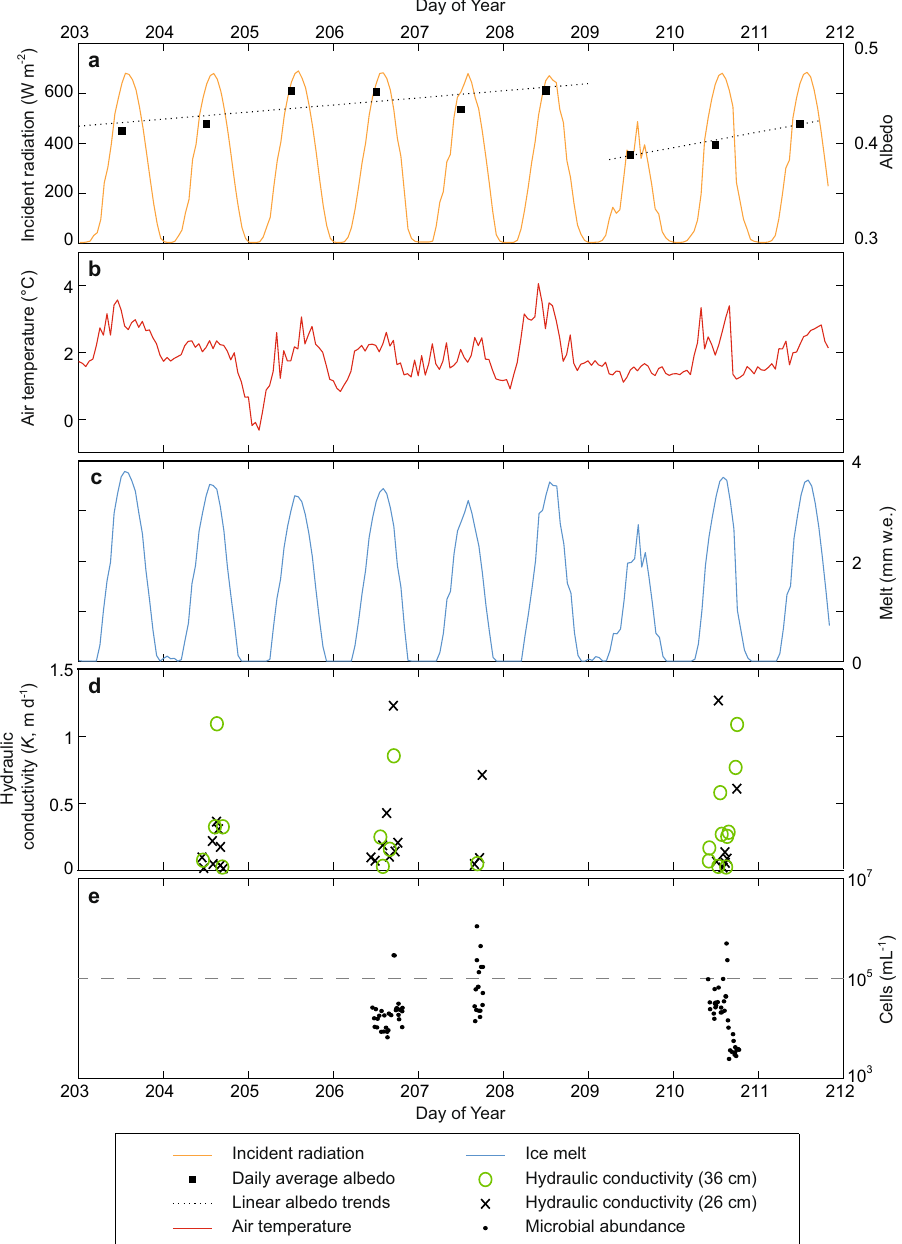
Fig. 2 Time-series plots of hydrometeorological variables at the S6 weather station location during the study period in 2014. a Record of incident shortwave radiation and daily mean surface albedo with associated temporal trends before and after the cloudy conditions on day of year (DOY) 209. b Air temperature over the 9-day study period. c Estimated ice melt according to a simple point-based energy balance model (see Methods). d The derived weathering crust hydraulic conductivity ( K ) values for 26 and 36 cm deep auger holes. e Microbial abundance in the recharge water samples associated with individual bail-recharge experiments; note the 10 5 cells mL − 1 threshold (dashed line) used to de fi ne samples as outliers (see